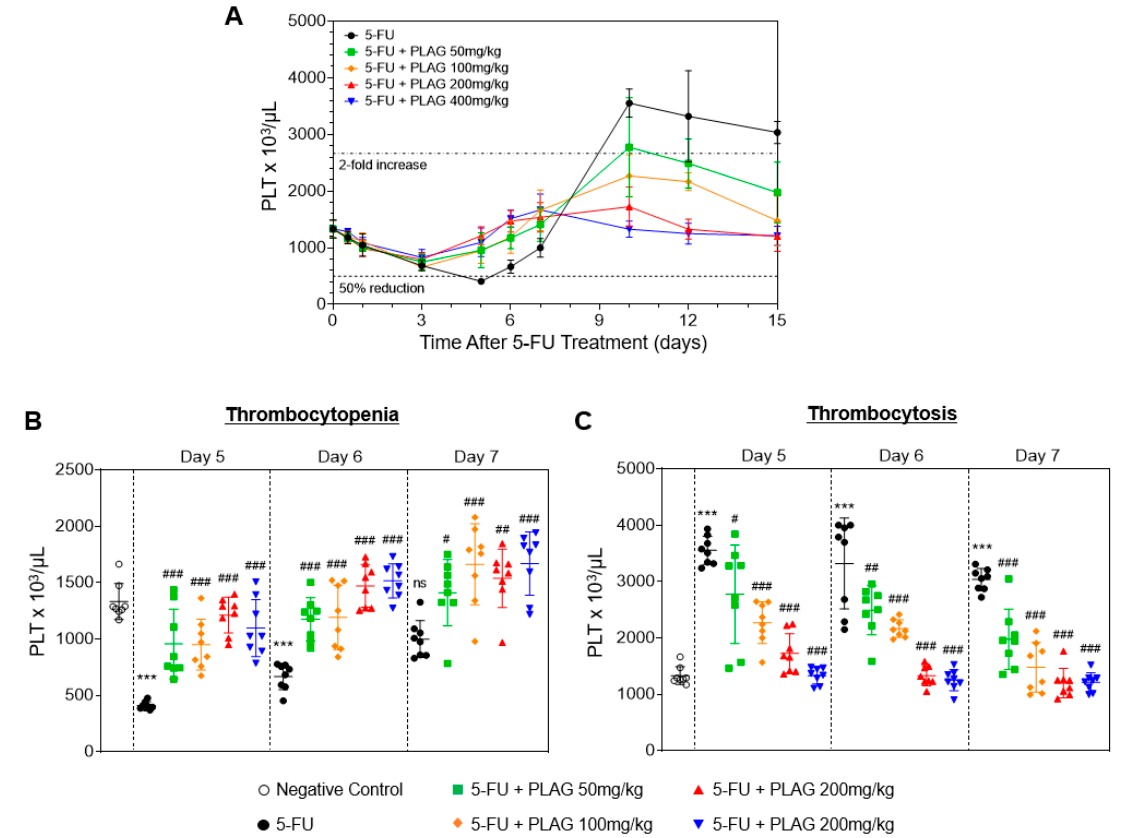
Figure 3. PLAG prevents 5-FU-induced thrombocytopenia and thrombocytosis. Mice ( n = 8 males per group) were intraperitoneally injected to 100 mg / kg of 5-FU immediately followed by oral administration of 50, 100, 200, and 400 mg / kg of PLAG, continuing daily until day 15. ( A ) E ff ect of PLAG administration on the kinetics of peripheral platelets after 5-FU injection for 15 days. The peripheral platelet counts are presented as dots ( B ) on days 5, 6, and 7 and ( C ) on days 10, 12, and 15. The complete blood counts (CBCs) data are representative of five independent experiments with eight mice per group. * indicates negative control vs. 5-FU and # indicates 5-FU vs. 5-FU + PLAG-treated groups. * / # p < 0.05, ** / ## p < 0.01, *** / ### p < 0.001. ns., not significant.